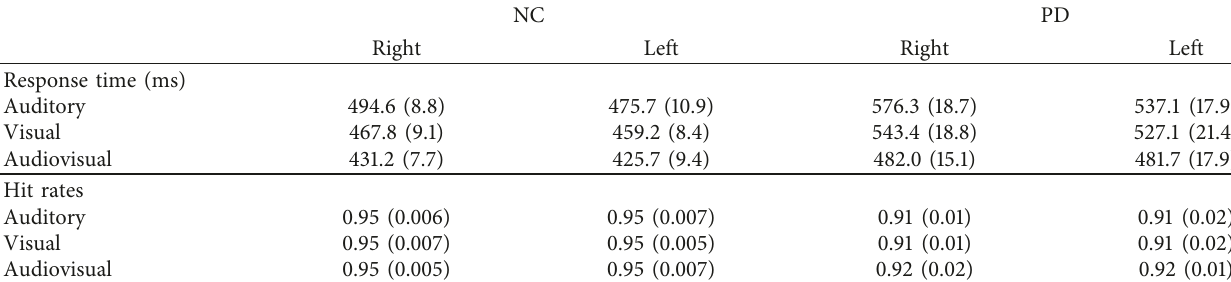
Table 3: The mean response times and hit rates for NC and PD